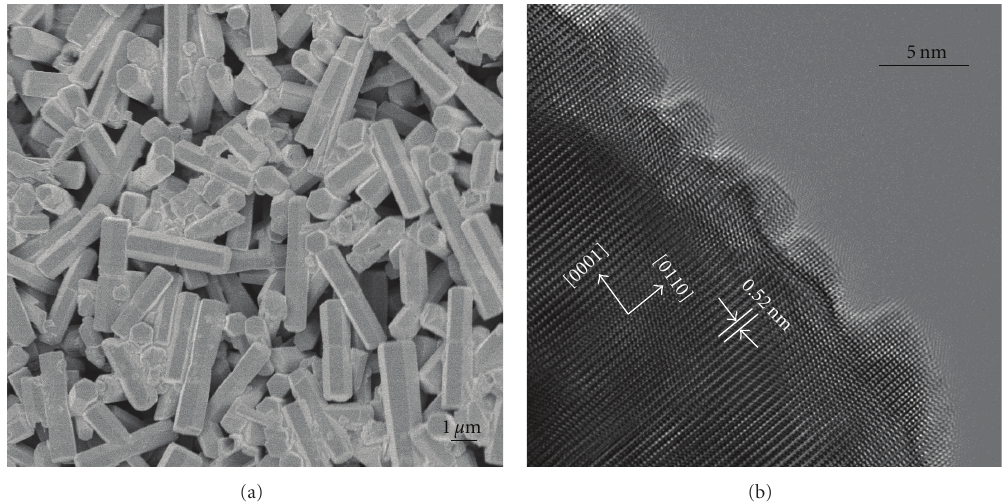
Figure 1: (a) FESEM image and (b) HRTEM image of the hydrothermally synthesized ZnO nanorods.